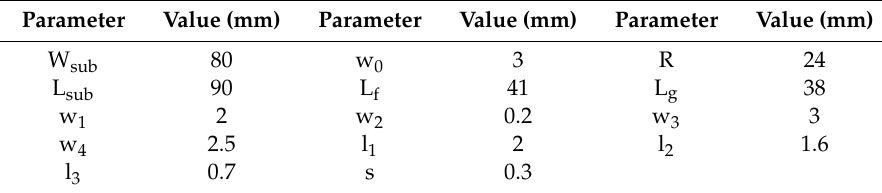
Figure 3. The layout of the UWB monopole antenna. Table 2. Antenna parameters and their